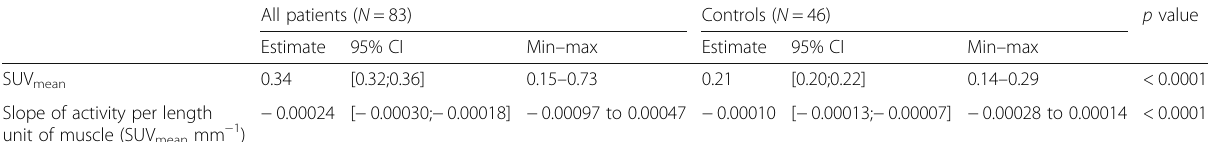
Table 3 Results of semi-automated quantification of thigh muscles in patients with polymyositis or dermatomyositis and control persons All patients ( N = 83) Controls ( N =46) p value Estimate 95% CI Min – max Estimate 95% CI Min – max SUV mean 0.34 [0.32;0.36] 0.15 – 0.73 0.21 <